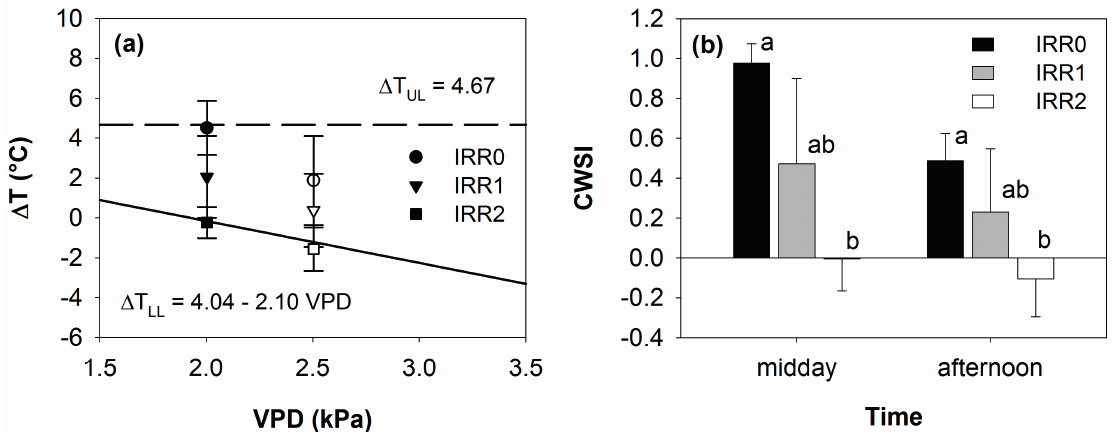
Figure 7. Lower and upper limits of the relationships between Δ T and VPD for the determination of the crop water stress index (CWSI) in maize ( a ); average and standard deviation of the CWSI computed on the plots treated with three different water regimes on the midday and afternoon flights ( b ). CWSI analyzed with the non-parametric Kruskal–Wallis test. The results of the test are evidenced by letters on the plots. Statistically different ( p < 0.05) medians are designated with different